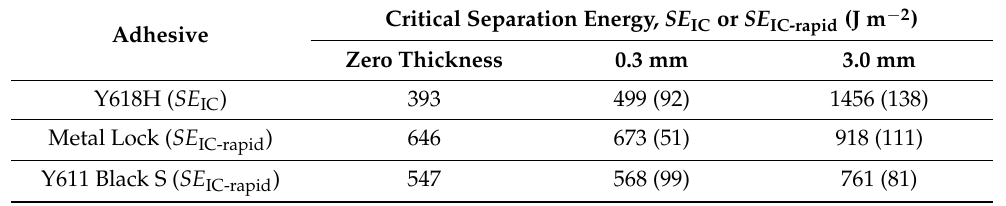
Figure 10. Relations of the critical separation energy and apparent crack length of ( a ) Y618H, ( b ) Metal Lock, and ( c ) Y611 Black S adhesive. Table 2. Mean values of the critical separation energy for Y618H, Metal Lock, and Y611 Black S adhesive of di ff erent thicknesses (standard deviation is mentioned in parentheses).